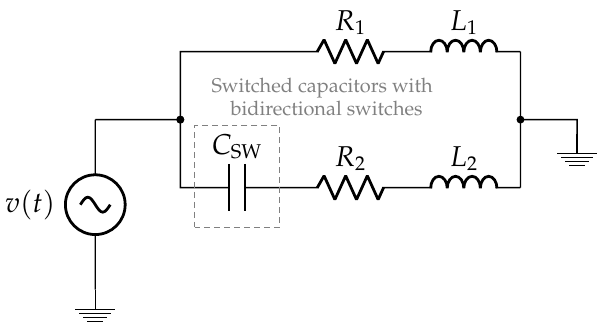
Figure 6. A harmonic voltage source with two-phase RL load and switched